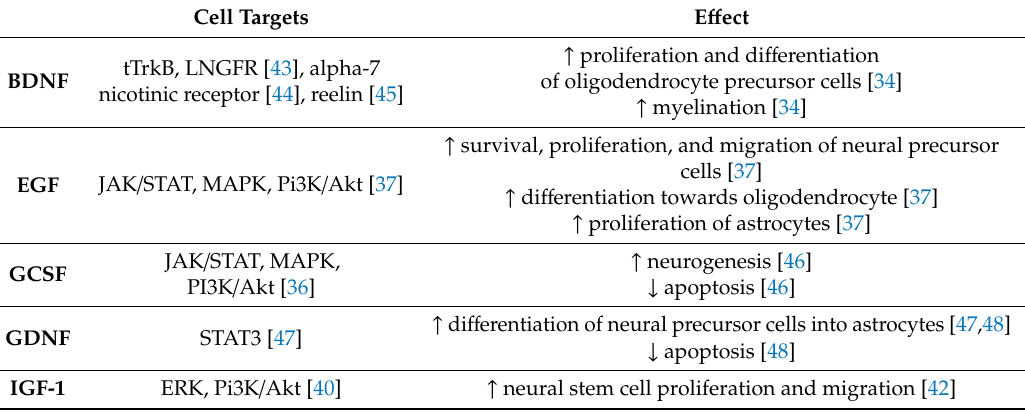
Table 1. Neuroprotective properties of growth factors proposed for adjuvant stem cell therapy.